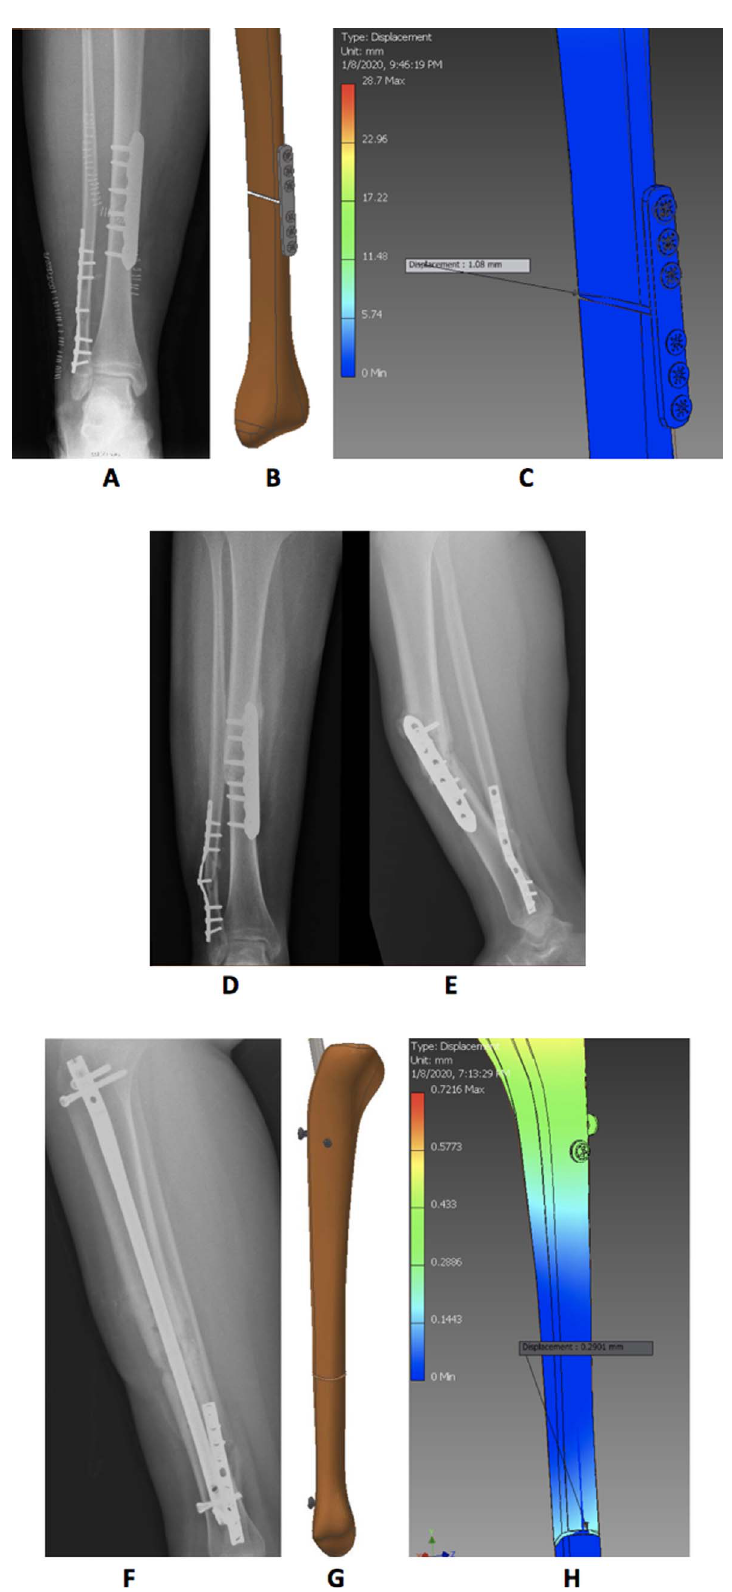
Figure 3. A – C: After locking plate fi xation; (A) immediate postoperative X-ray, (B) 3-D model created, (C) fi nite element analysis of the model. D and E: X-rays after 4 weeks with failed fi xation; (D) anteroposterior view, and (E) lateral view. F – H: After revision of fi xation with IMN; (F) postoperative X-ray, (G) 3-D model created, (H) fi nite element analysis of the